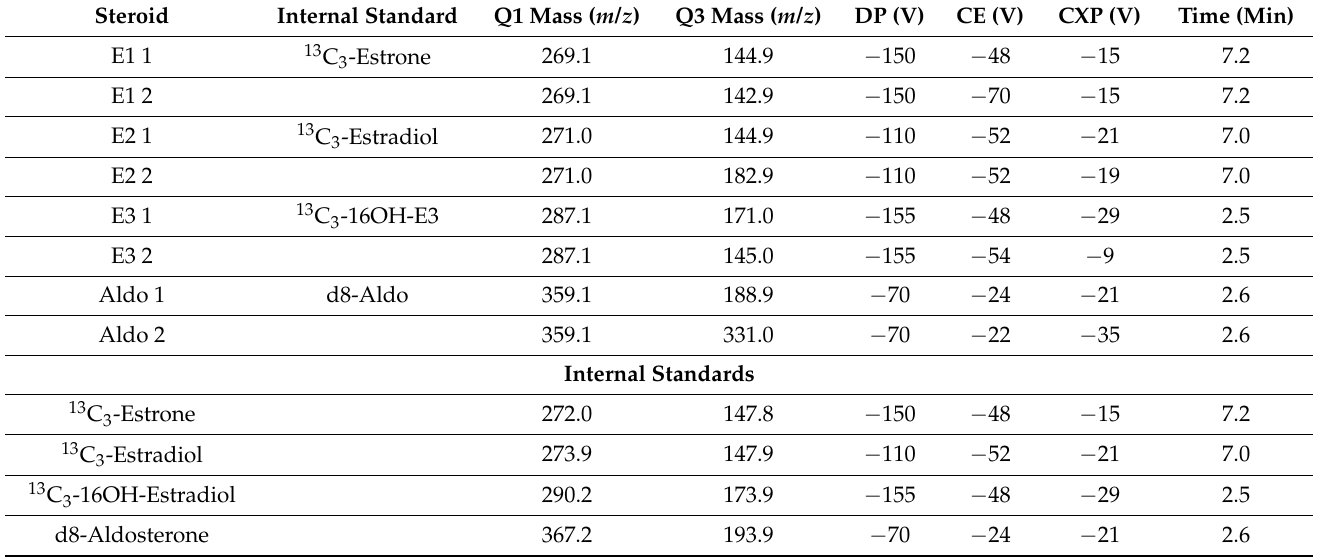
Table 2. Negative ion multiple reaction monitoring (MRM) parameters for each steroid and isotopi- cally labelled internal standards, as analysed on a QTrap 6500+ mass spectrometer following electro- spray ionisation. E1—Estrone; E2—Estradiol; E3—16-hydroxyestradiol; Aldo—Aldosterone; DP— Declustering Potential; CE—Collision Energy; CXP—Collision Cell Exit Potential; RT—Retention Time. Quantifier (1) and Qualifier (2), indicated